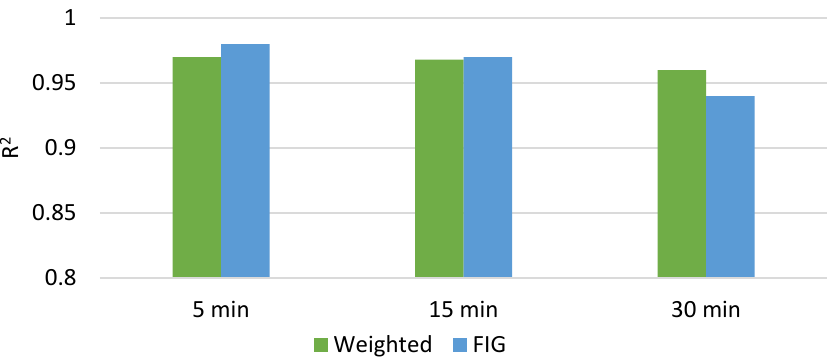
Figure 6. Comparison of the coefficient of determination for the methods implemented and compari- son according to the time horizon for the GHI forecast.